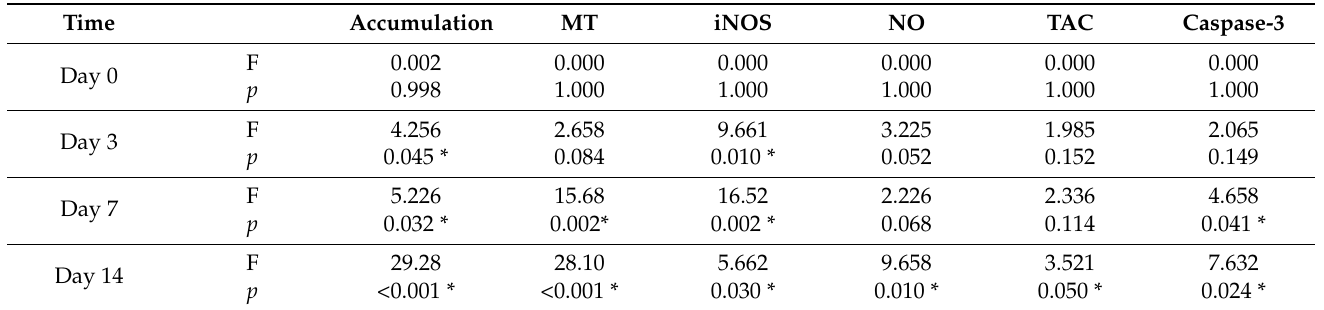
Table 2. Interaction effects of Zn concentration and water